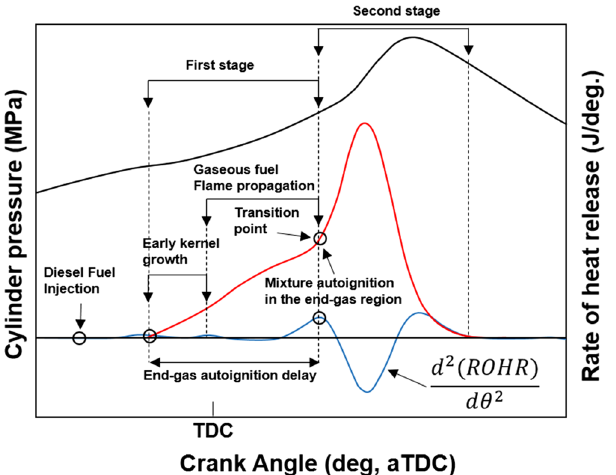
Figure 5. PREMIER combustion phase of MPDF 26 .